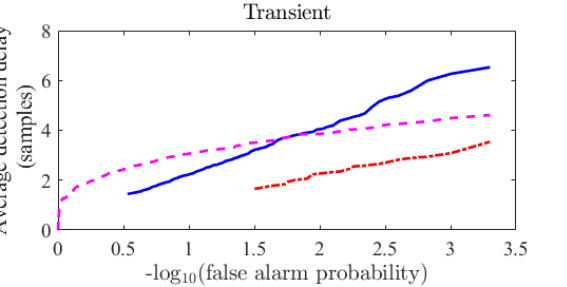
Figure 6. Performance comparison between the methods for detection of sag, transient, and swell disturbances with variance σ 2 = 0.1.